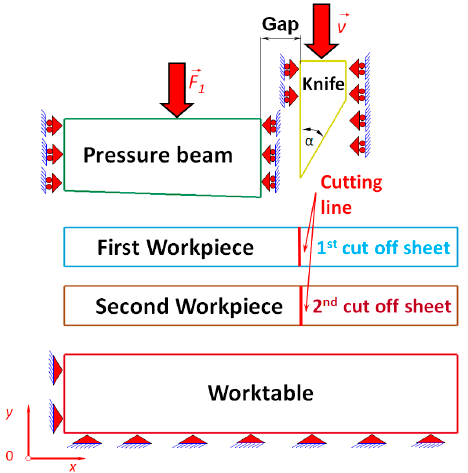
Figure 2. Physical model of a bundle consisting of two sheets being cut.